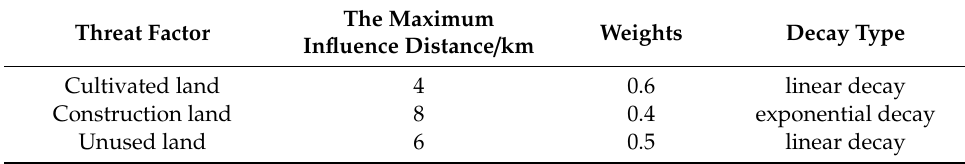
Table 3. Threat factors and their characteristic